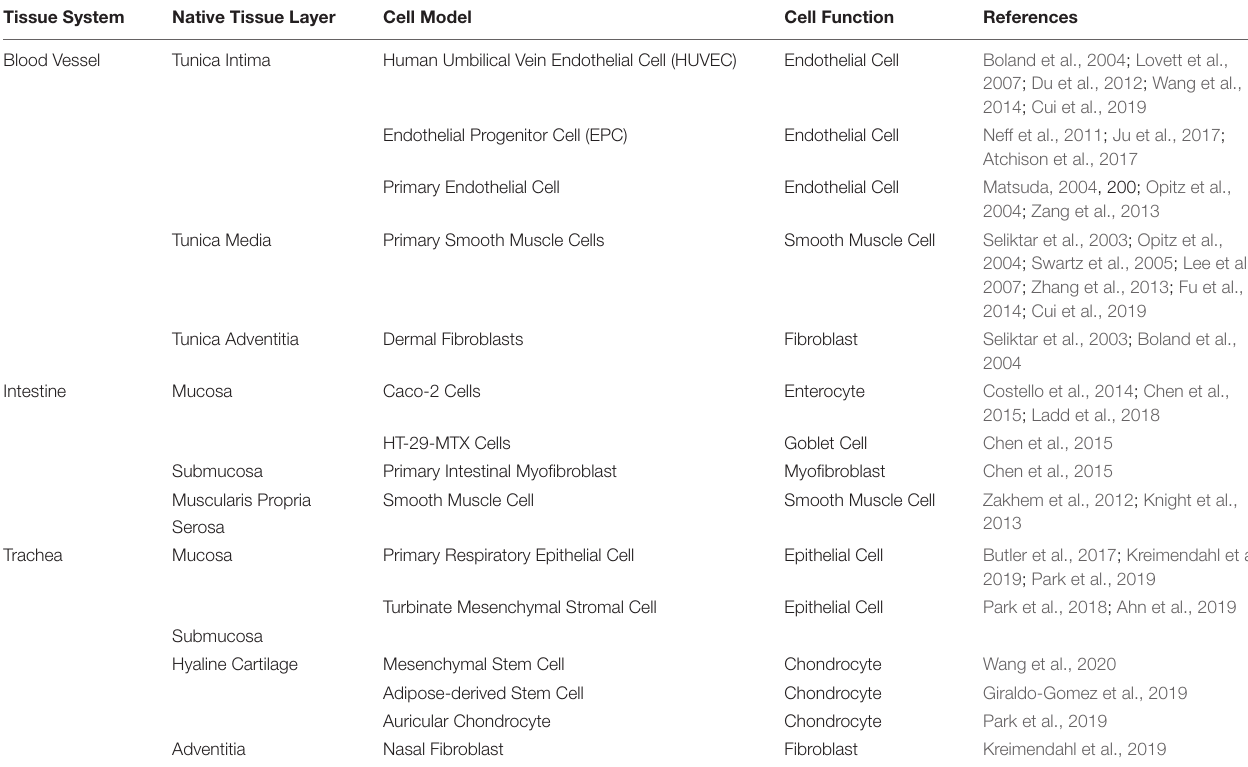
TABLE 2 | Commonly used cells for tissue engineered models of vasculature, the intestine, and the trachea.